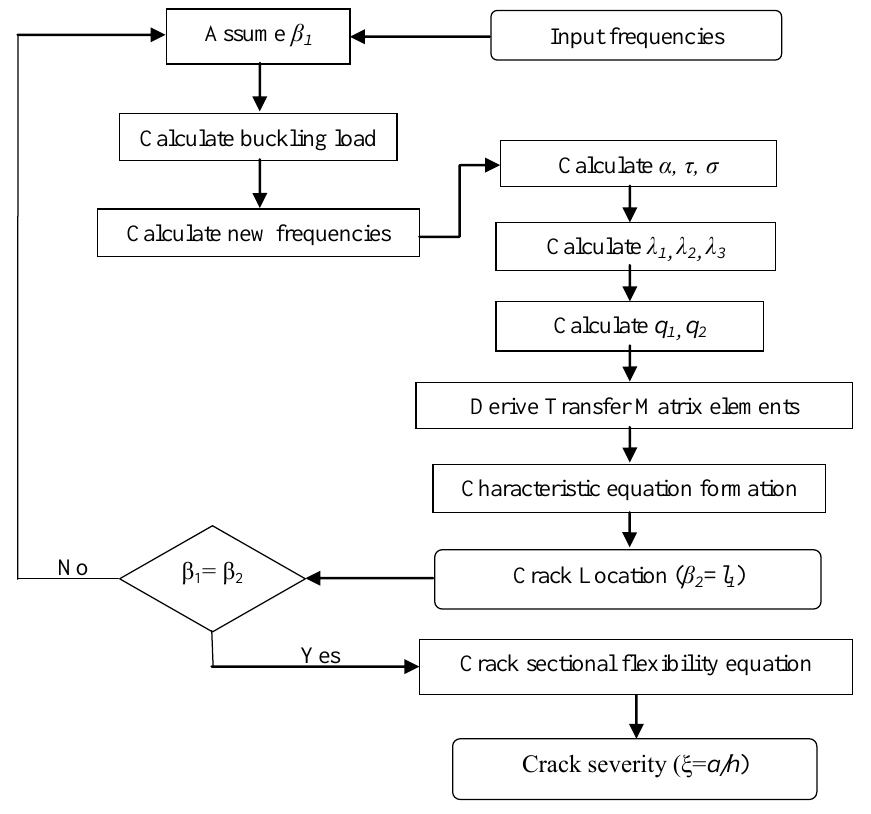
Fig. 8. Revised algorithm for damage detection of axially loaded beam with a